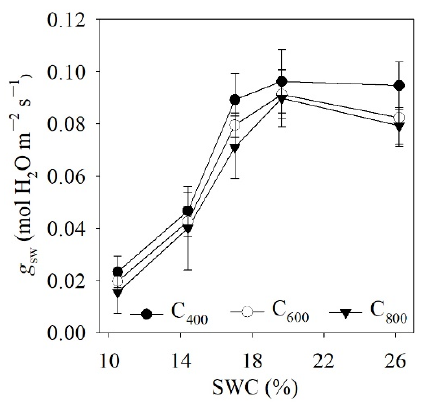
Figure 2. Response of measured leaf stomatal conductance (g sw, mol H 2 O·m − 2 ·s − 1 ) to three CO 2 con- centrations ( C a ) × five soil water contents (SWC). C 400 , C 600 , and C 800 are C a of 400, 600, and 800 μ mol·mol − 1 . Data represent mean values ± SD.